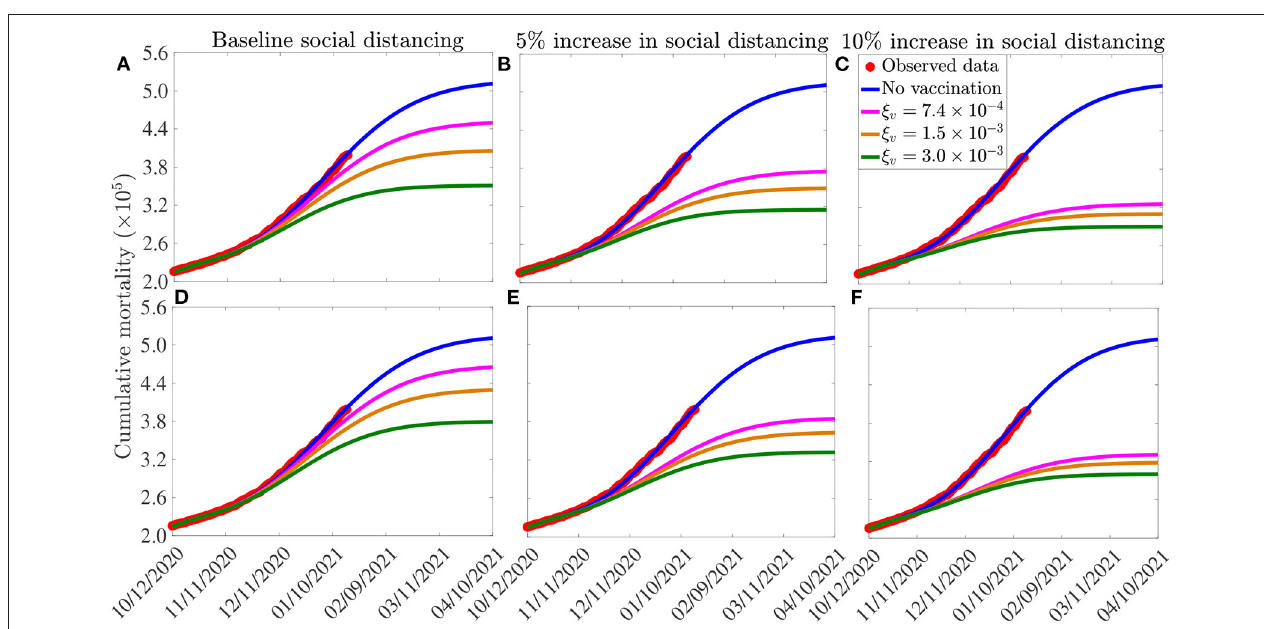
FIGURE 6 | Assessment of the combined impact of vaccination and social-distancing on cumulative mortality. Simulations of the model (2.5)–(2.6), depicting cumulative as a function of time, for the three vaccines considered in this study and various levels of increases in baseline social-distancing compliance starting from October 12, 2020 ( c s ). (A–C) Pfizer or Moderna vaccine. (D–F) AstraZeneca vaccine. The vaccination rates ξ v = 7.4 × 10 − 4 , 1.5 × 10 − 3 per day, and 3.0 × 10 − 3 per day correspond, respectively, to vaccinating ∼ 2.5 × 10 5 , 5.0 × 10 5 and 1.0 × 10 6 people per day. Other parameter values of the model used are as presented in Tables 3 , 4